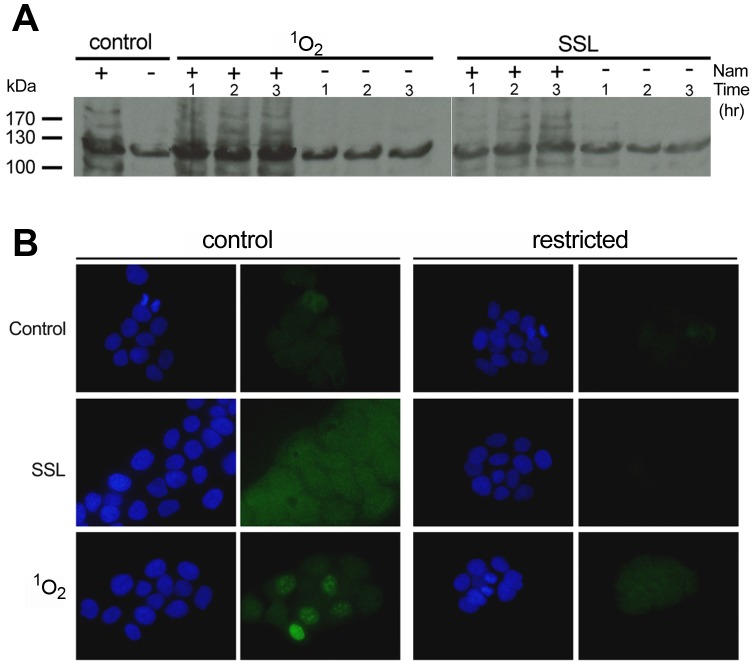
Effect of niacin restriction on PARP activation by photodamage.Polymer immunoblotting and immunocytochemistry of HaCaT keratinocytes grown for 14 days under control (+) or restricted (−) niacin (Nam) and exposed to photodamage. Cells treated with singlet oxygen stress (1O2) or solar simulated light (SSL) were analyzed by (A) Western blots using a PAR antibody and (B) immunostaining using a PAR antibody (green) and nuclear counterstaining with DAPI (blue).